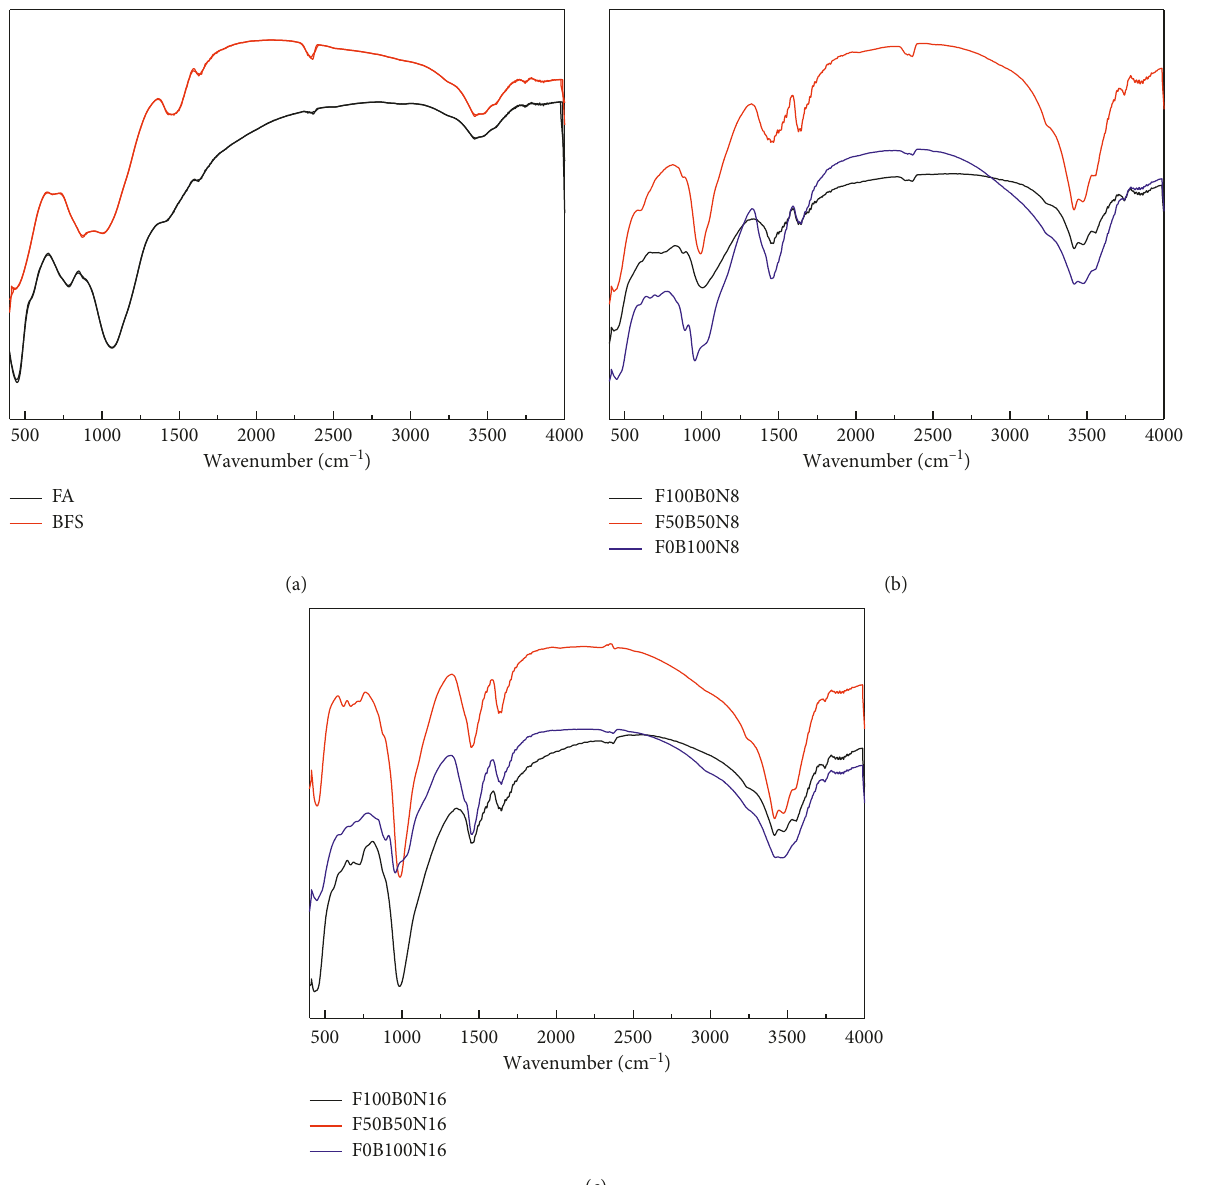
Figure 3: FTIR of (a) FA and BFS and geopolymer pastes with (b) 8M NaOH solution and (c) 16M NaOH